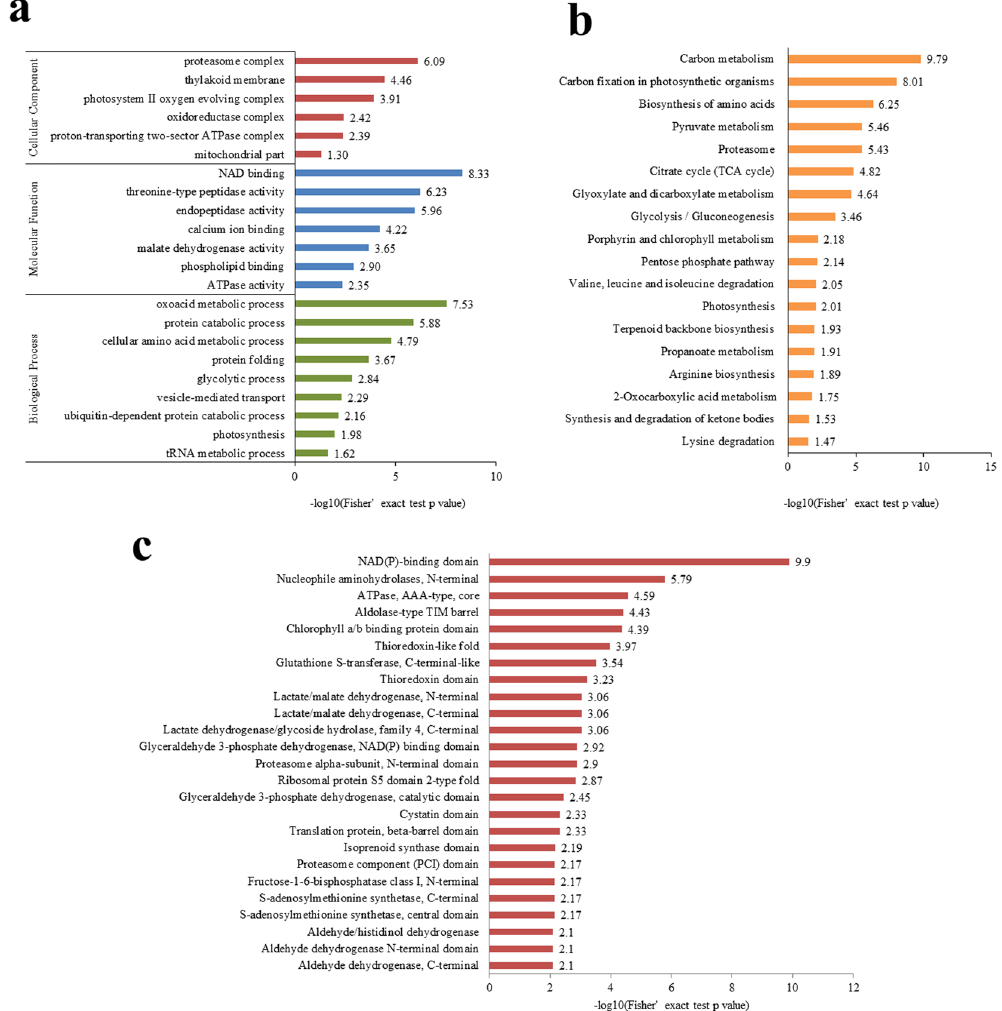
Figure 4. Enrichment analysis of crotonylated proteins. ( a ) GO-based enrichment analysis of crotonylated proteins in terms of cellular component, molecular function, and biological process. ( b ) KEGG pathway-based enrichment analysis. ( c ) Protein domain enrichment analysis. The numbers in X axes represent the value of significant analysis. When the value is greater than 1.3, the p value is less than 0.05, which means the data is statistically